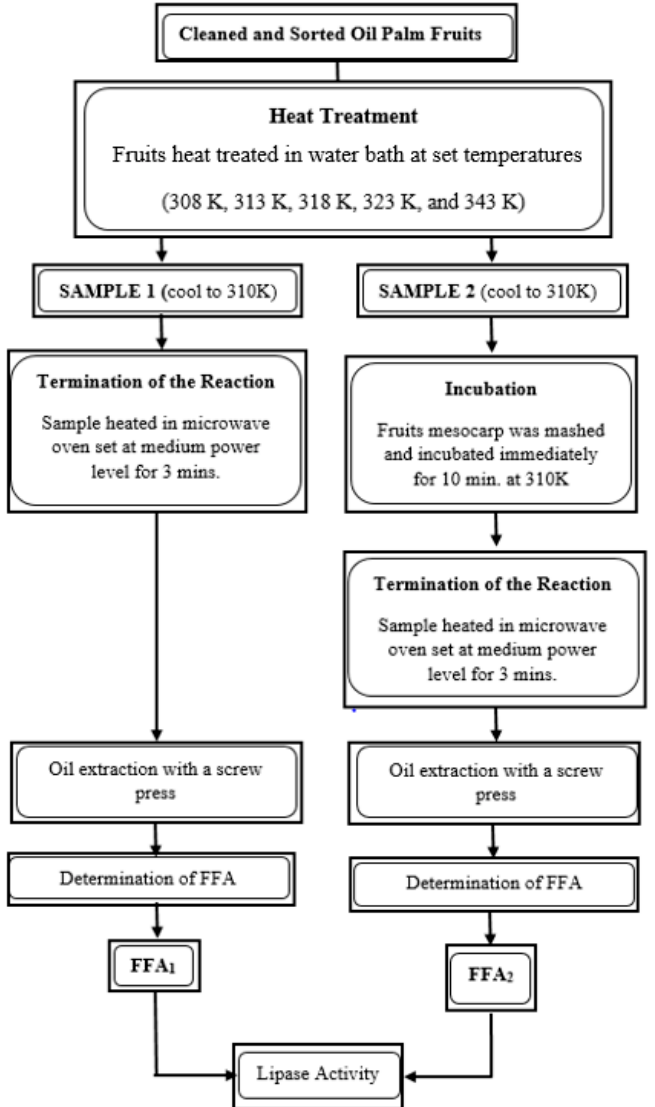
Figure 2. Illustration of the procedure for the determination of in vivo activity of endogenous lipase activity using wounding technique.